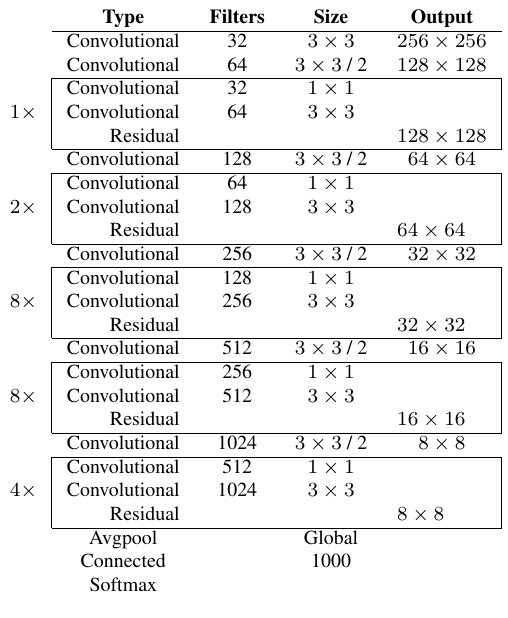
Table 1. The YOLO-TARGET architecture.